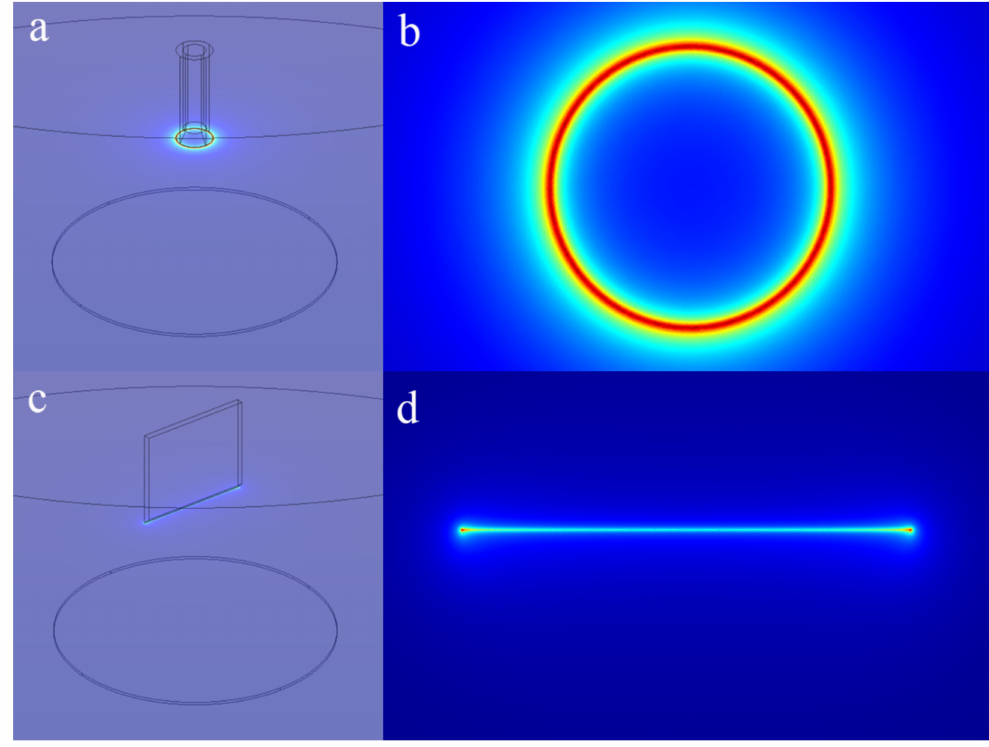
Figure 14. Distribution of the induced electric field: ( a , b ) annular tip; ( c , d ) straight-line